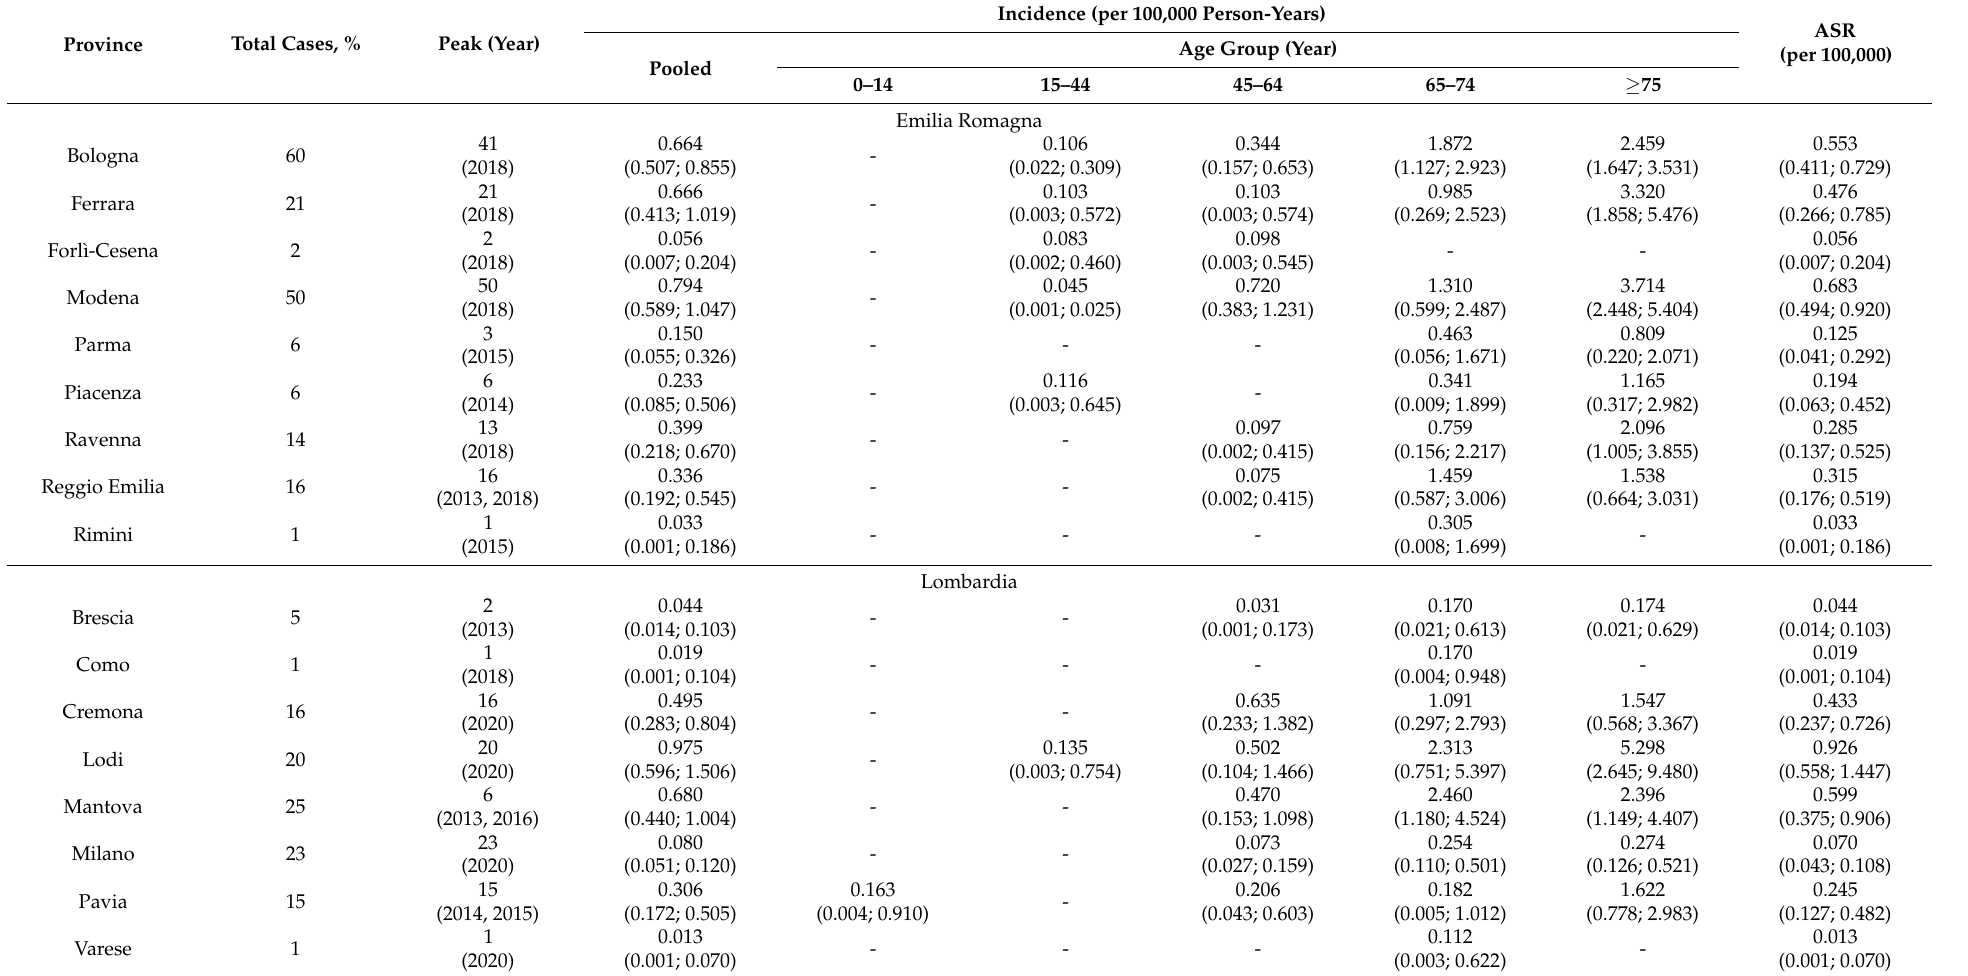
Table A3. Epidemiology of West Nile Neuro-Invasive Disease (WNND) in Italy (2012–2020) by Age Groups According to Official Surveillance Data of Italian National Health Institute (in Italian, ISS). Note: ASR = Age Standardized Incidence